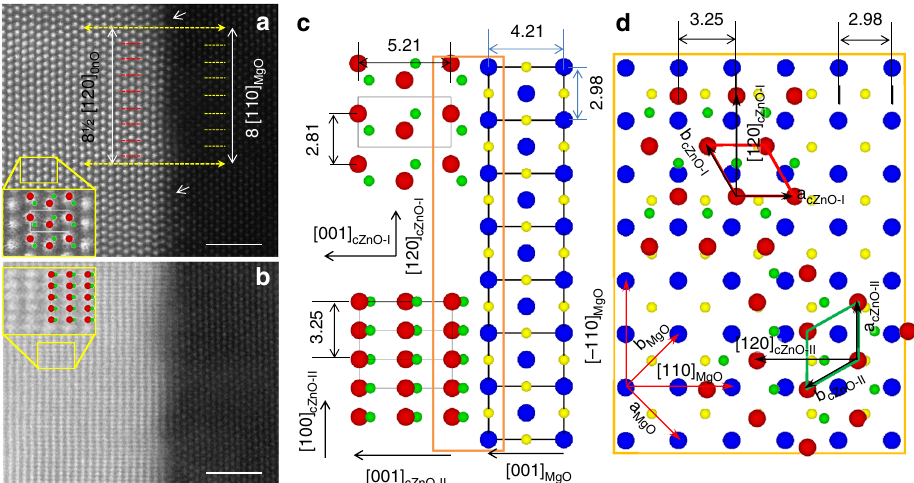
Fig. 2 Orientation relationship for c-ZnO. Cross-section scanning transmission electron microscopy (STEM)-high-angle annual dark- fi eld (HAADF) images of ( a ) c-ZnO-I and ( b ) c-ZnO-II domains of polar fi lm. Scale bar, 2 nm. The beam is parallel to the [110] MgO direction. The high contrast dots on the left correspond to Zn atoms, while weak contrast dots in the right correspond to Mg atoms. The O atom is invisible due to its low atomic number. The insets show the magni fi ed images from the area outlined by the yellow rectangles with the atomic projection of [100] cZnO-I in ( a ) and [ − 1 − 20] cZnO-II in ( b ) embedded (red: Zn, green: O epi , yellow: O sub , blue: Mg). [100] cZnO-I is aligned with [110] MgO , showing centered-rectangle atomic arrangement. The c-ZnO- II is rotated 90° along [001] direction in terms of ZnO-I and viewed along [ − 1 − 20] cZnO-II , showing close-packed rectangular atomic arrangement. The two yellow dashed arrows in a indicate the alignment of a ZnO row with respect to an MgO row. c Projection of the interface for c-ZnO-I along [100] direction (upper panel) and c-ZnO-II along [ − 1 − 20] direction (lower panel) derived from STEM images. d Top view (one layer of (001) ZnO plane on top of one layer of (001) MgO plane) of the interface, which is the interface area outlined by the brown rectangle in c (rotated 90° clockwise). The unit cell of the c-ZnO-II domain (outlined by green parallelogram) is rotated 90° from that of the c-ZnO-I domain outlined by red